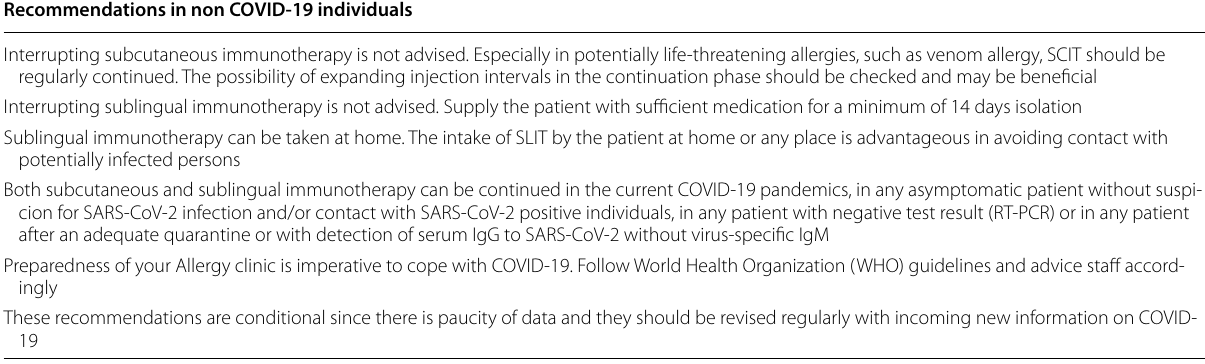
Table 1 AIT recommendations (adapted from Klimek et al. 2020), [19] Recommendations in non COVID-19